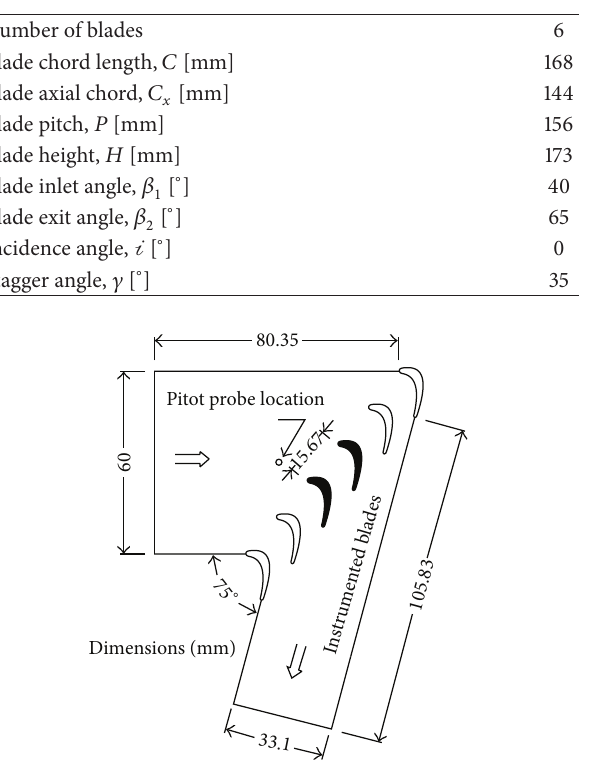
Table 1: Cascade parameters.